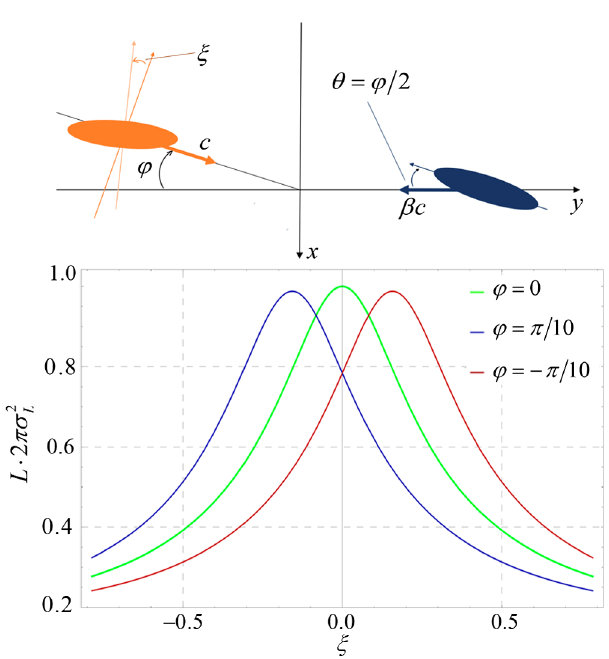
FIG. 6. The luminosity depending on the angle of tilt ξ of the front of a laser pulse for the long pulse ( σ Ly = σ L ¼ 5 ).